Question: Is the quantity shown trending increasing or decreasing?
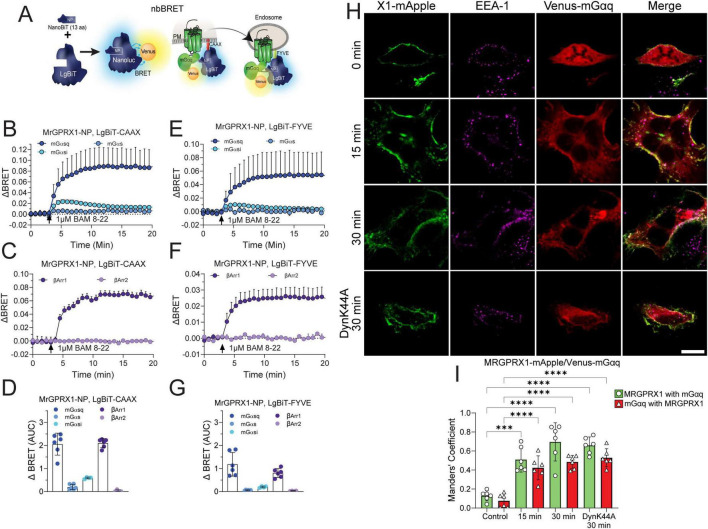
Answer: increasing